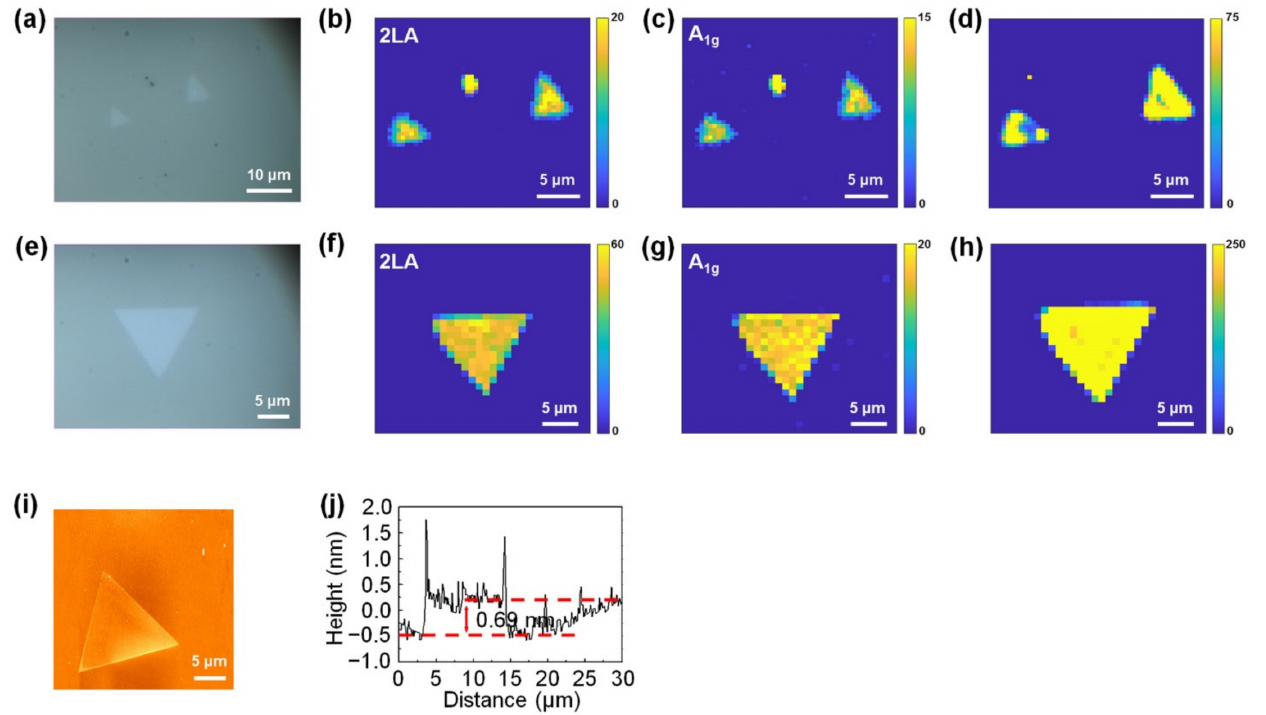
Figure 7. Conventional CVD growth and carbon cloth-assisted CVD growth of monolayer WS 2 . ( a ) Optical image of monolayer WS 2 synthesized using the conventional CVD method. ( b , c ) Raman maps of monolayer WS 2 synthesized using the conventional CVD method, taken at the 2LA mode and the A 1g mode of WS 2 , respectively. ( d ) PL map of monolayer WS 2 synthesized using the conventional CVD method. ( e ) Optical image of monolayer WS 2 synthesized using the carbon cloth-assisted CVD method. ( f , g ) Raman maps of monolayer WS 2 synthesized using the carbon cloth-assisted CVD method, taken at the 2LA mode and A 1g mode of WS 2 , respectively. ( h ) PL map of monolayer WS 2 synthesized using the carbon cloth-assisted method. ( i , j ) AFM image and height line profiles of monolayer WS 2 synthesized using carbon cloth-assisted CVD